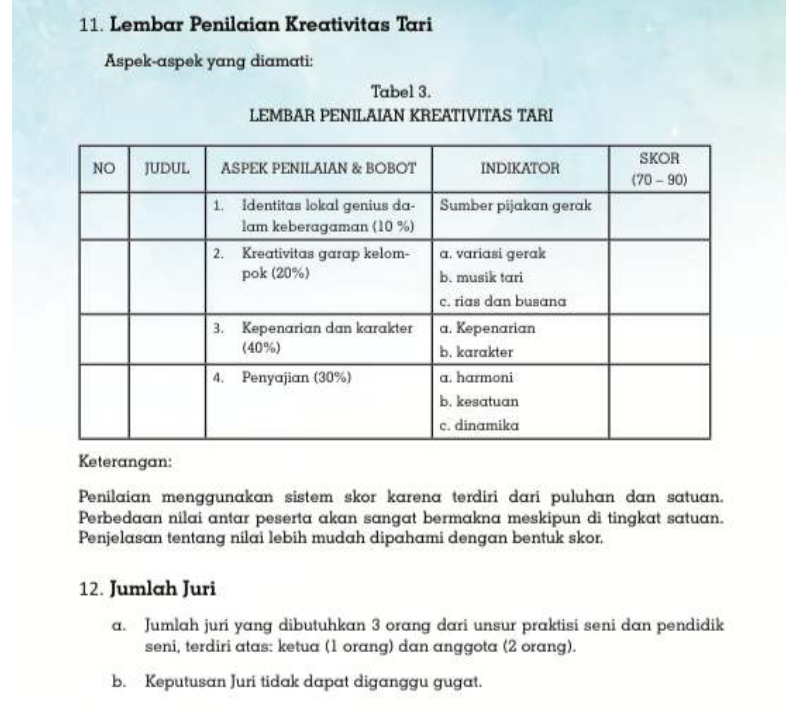
Figure 6. Judging Indicators and Criteria for the Jury in the 2018 FLS2N Dance Creativity Guideline based on the Ministry of Education and